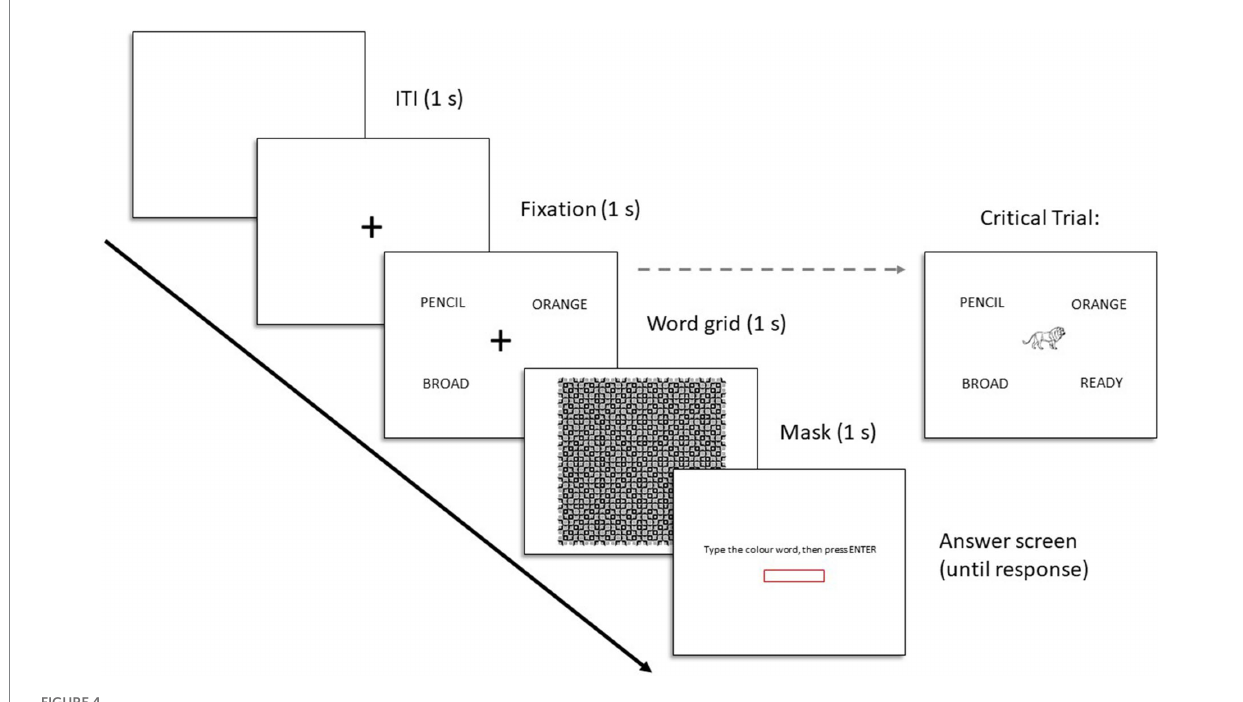
FIGURE 4 Trial structure for Experiments 2 and